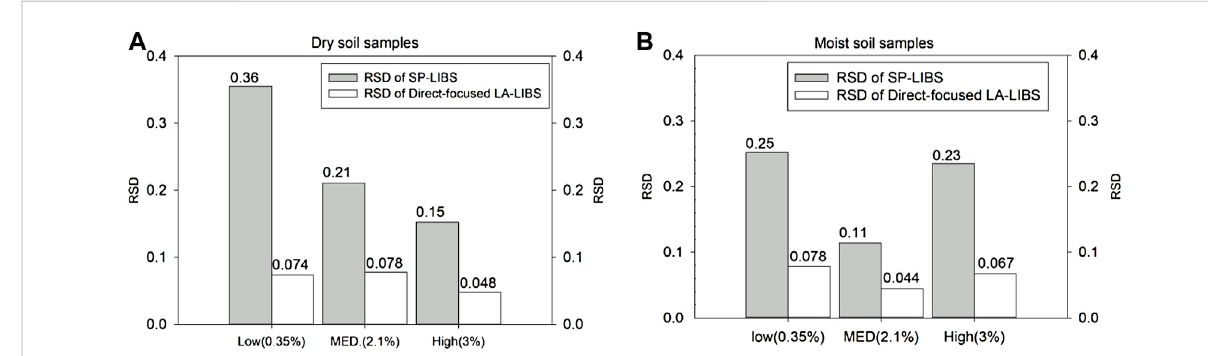
FIGURE 5 (A) Comparison of the RSD of SP-LIBS and direct-focused LA-LIBS for dry soil samples. (B) Comparison of the RSD of SP-LIBS and direct- focused LA-LIBS for moist soil